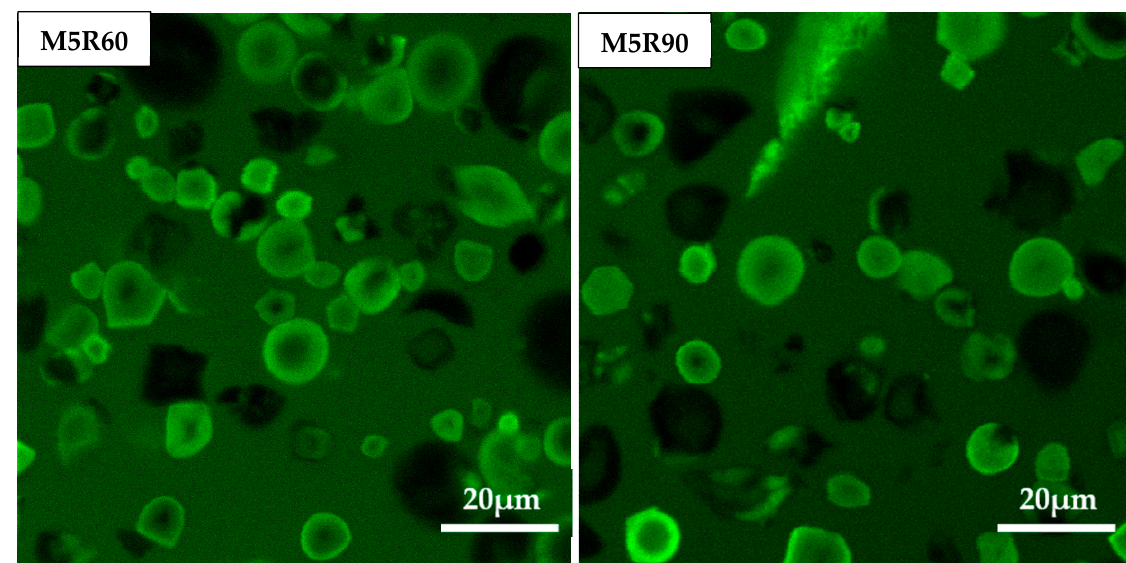
Figure 6. CSLM micrographs of GMP particles. Flour: wheat flour without mixing or resting. M3R0–M3R90: mixing for 3 min and resting for 0, 30, 60, and 90 min, respectively. M5R0–M5R90: mixing for 5 min and resting for 0, 30, 60, and 90 min, respectively.